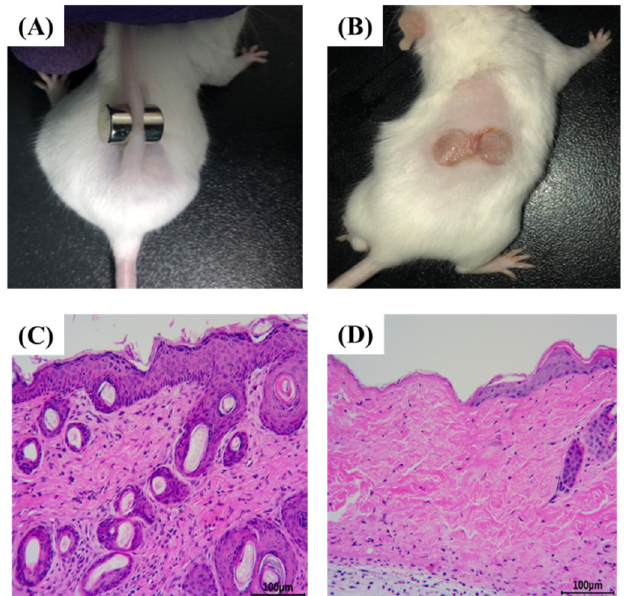
Figure 1. Establishment of PU in mice ( n = 3). ( A ) A pair of sterile circular magnets was used to establish the PU in mice. ( B ) All mice developed two ulcers after two I/R cycles. ( C ) The H&E staining of normal skin of mice (200×). ( D ) The H&E staining of PU model skin of mice (200×).